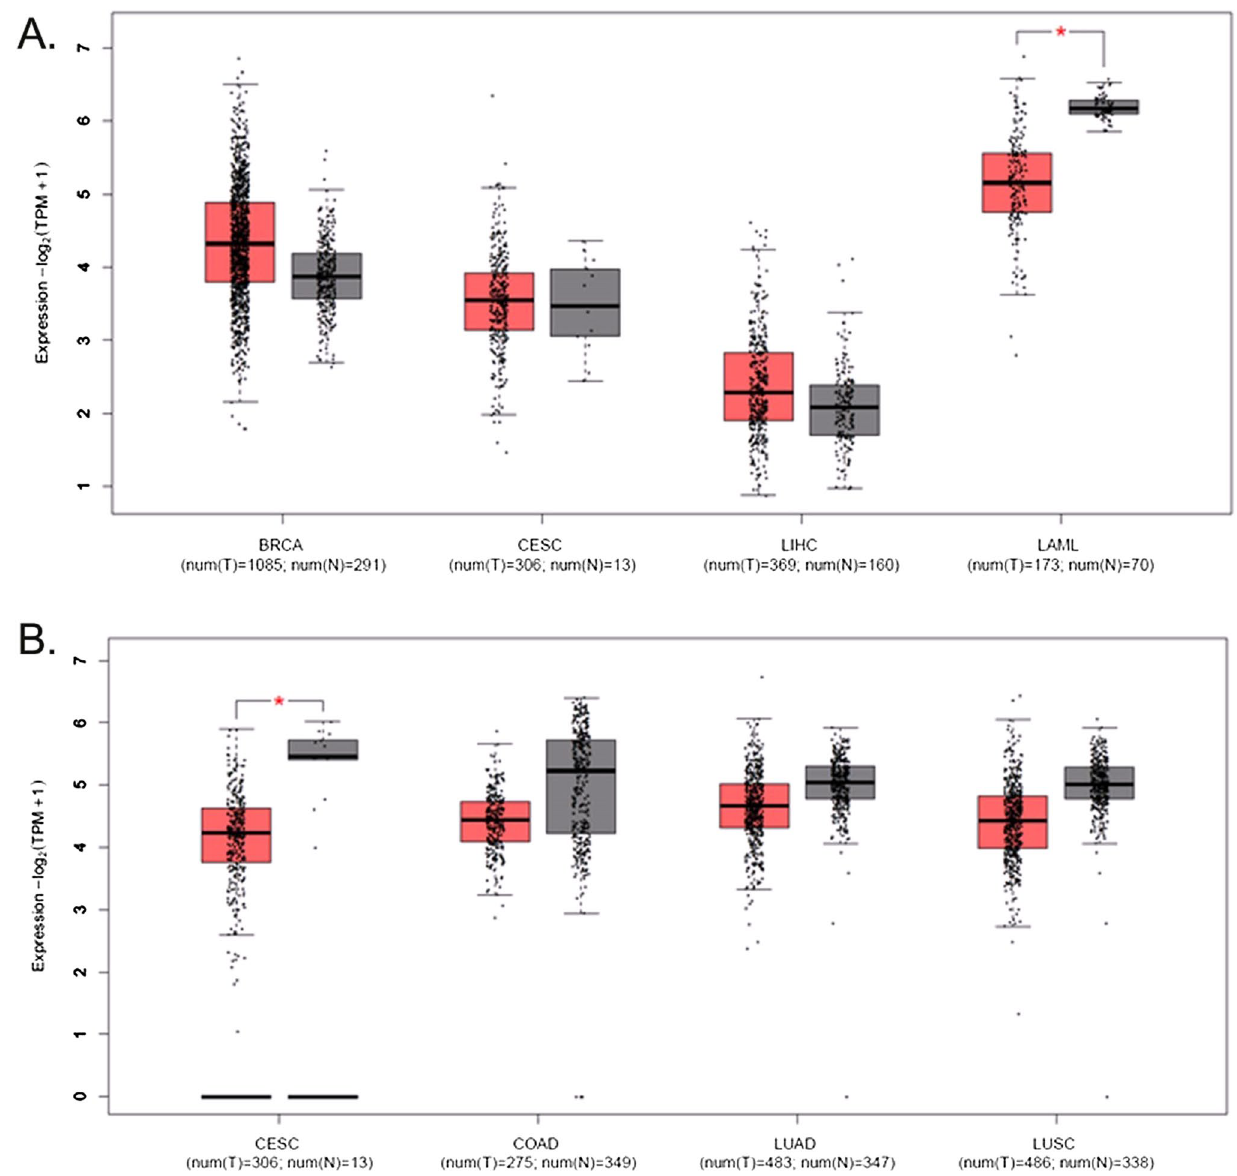
Fig. 2 Updated version of Figure